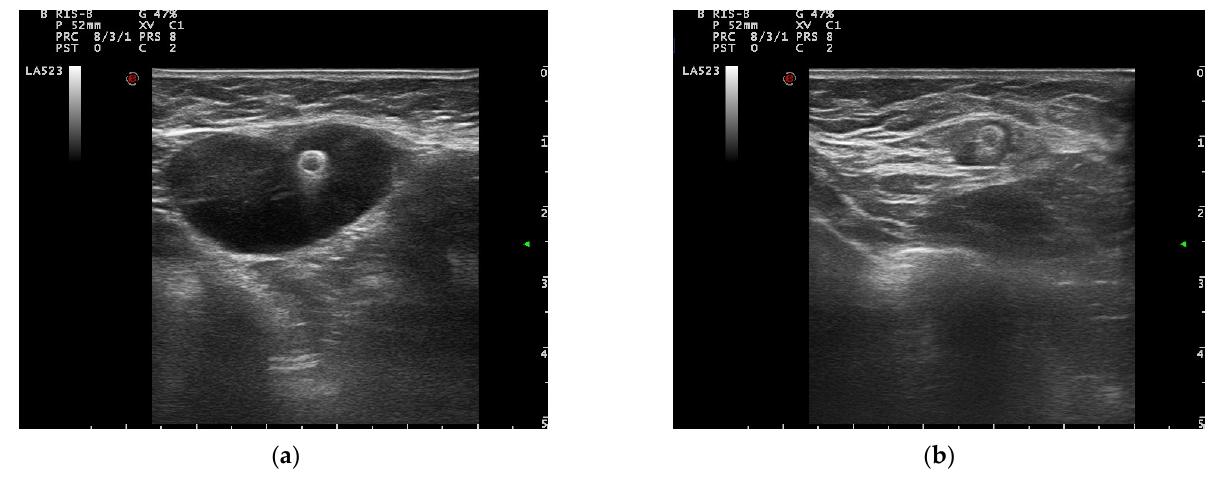
Figure 3. ( a ) Clip in breast lesion; ( b ) clip in a lymph